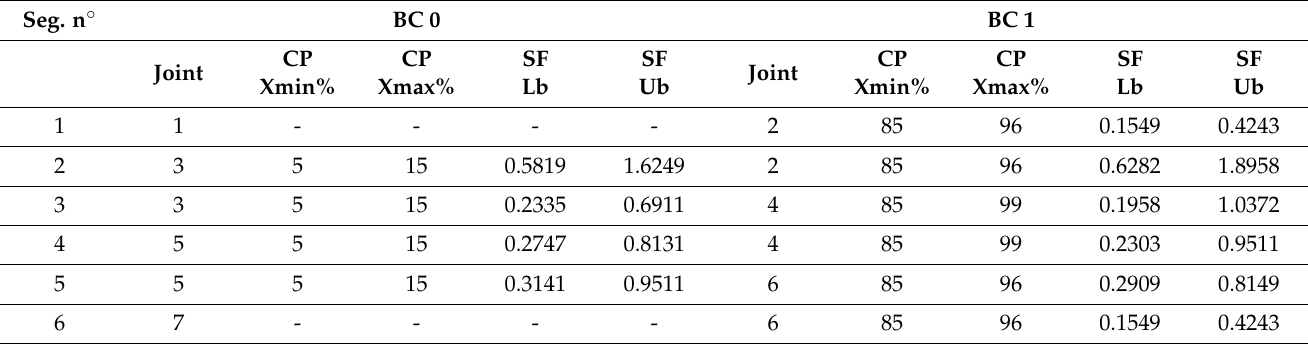
Table 5. BCPs user-defined bounds & SF evaluated upper and lower